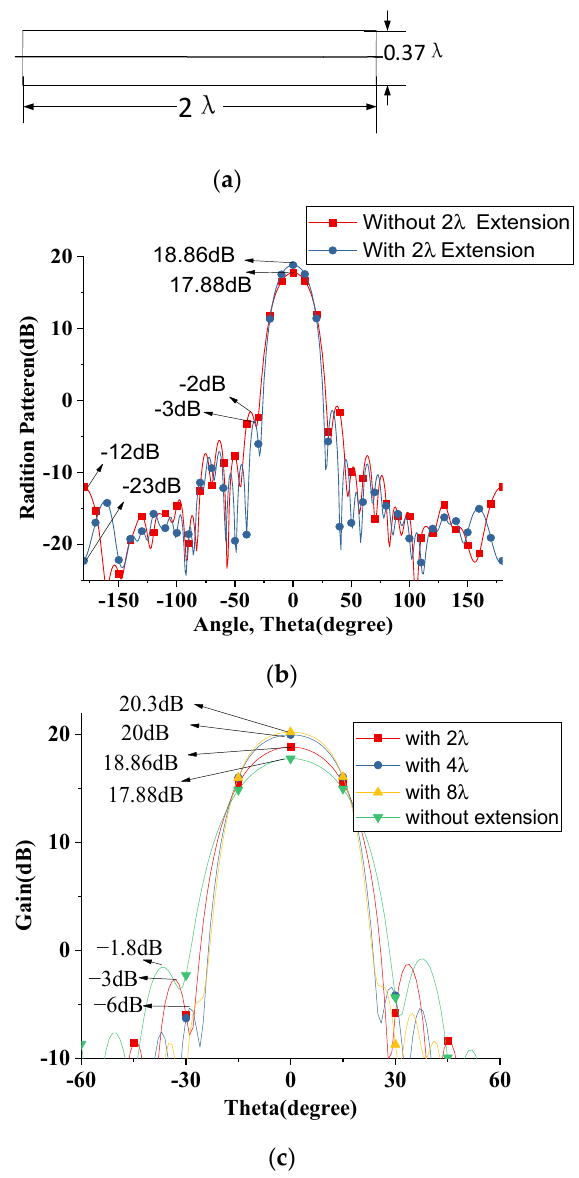
Figure 7. ( a ) Schematic of dielectric rod extension ( b ) Radiation pattern comparison with and without rod extension ( c ) Gain and length of the rod comparison.